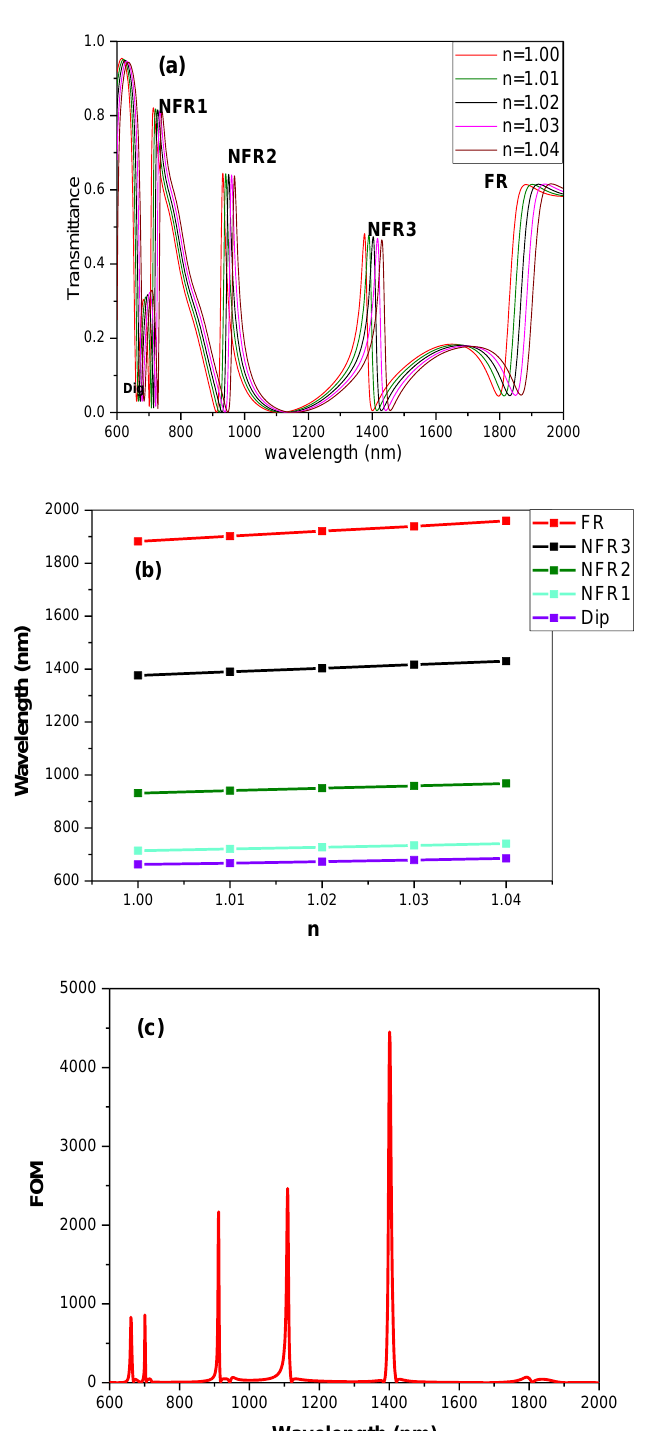
Figure 7. ( a ) The transmission spectra of the quadruple Fano resonances structure with variable n from 1.0 to 1.04. ( b ) The resonant wavelengths of Dip, NFR3, NFR4, NFR5 and FR with different n. ( c ) The FOM with different wavelengths of the quadruple Fano resonances structure.